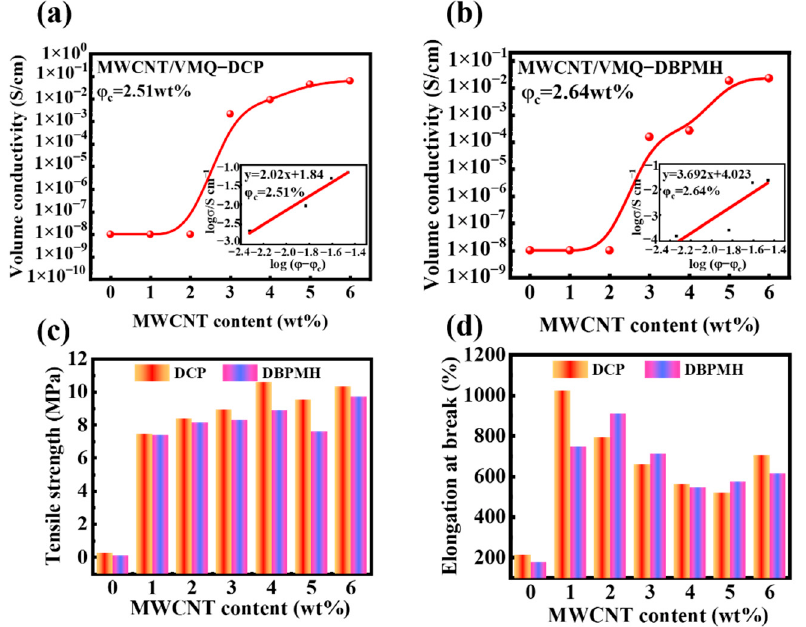
Figure 3. ( a ) Volumetric conductivity of the MWCNT/VMQ-DCP composites. ( b ) Volumetric conductivity of the MWCNT/VMQ-DBPMH composites. ( c ) Tensile strengths of the two composites with different vulcanizing agents. ( d ) Elongation breaks of the two composites with different vulcanizing agents.